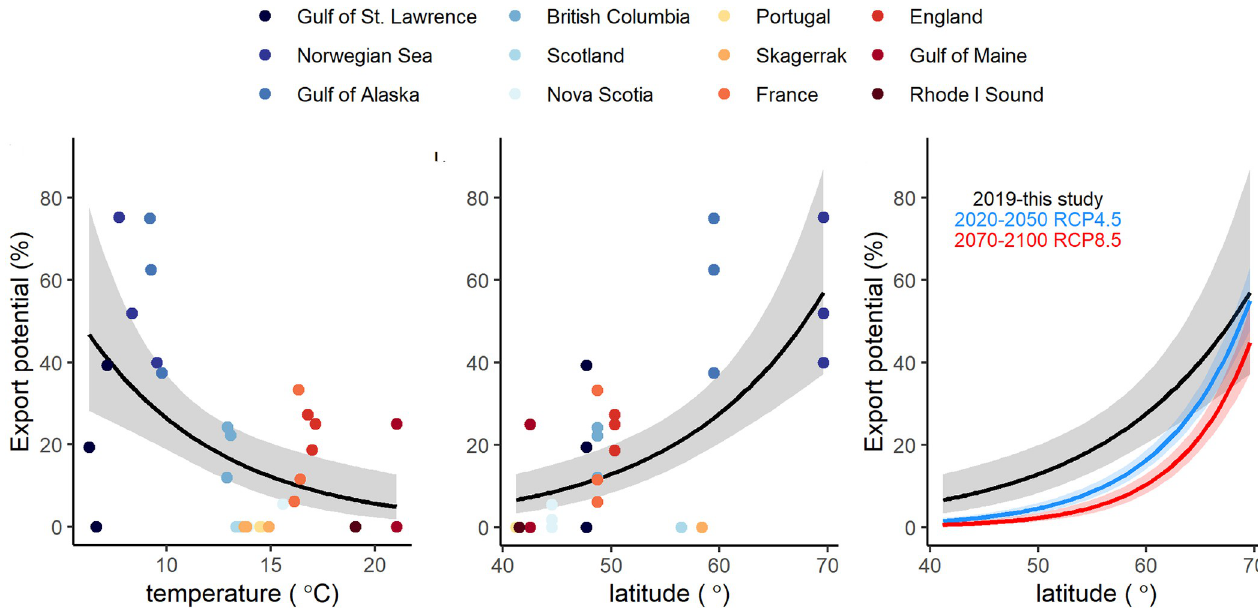
Fig 6. Export potential of kelp carbon with temperature and latitude. Relationships between export potential of kelp material to the deep ocean and (A) temperature at the sea floor and (B) latitude at our study sites. Export potential represents the percent of detrital material that could cross the shelf break (200 m isobath) and sink to the deep sea, which was calculated using decomposition rates and average coastal residence times (days) simulated for each site location [46] (S4 Fig). (C) Predicted changes in export based on predicted sea surface temperature increase under short-term (2020–2050) RCP4.5 and long-term (2070–2100) RCP8.5 scenario in the north polar and northern subtropical regions [50]. Colors (A, B) show regions and fitted lines shows generalized linear model with log link function, with 95% confidence interval shaded (Data E in S1 Data).